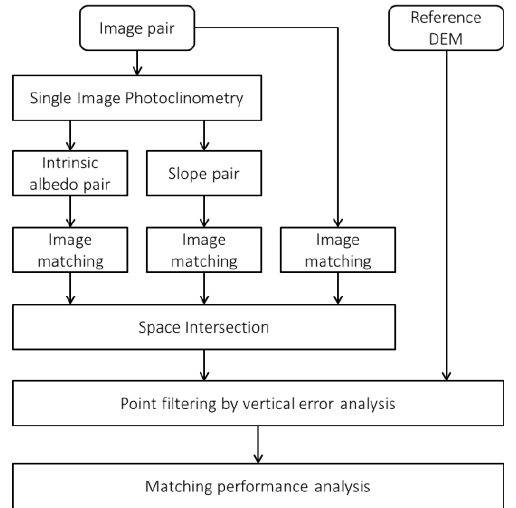
Figure 5. General procedure for experimental analysis